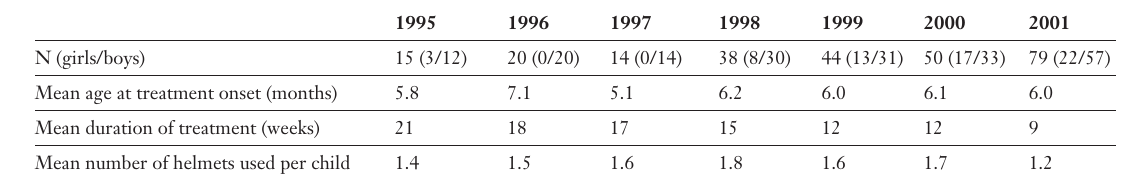
Epidemiology of patients treated with cranial remodelling orthosis in Lausanne from 1995 to 2001.